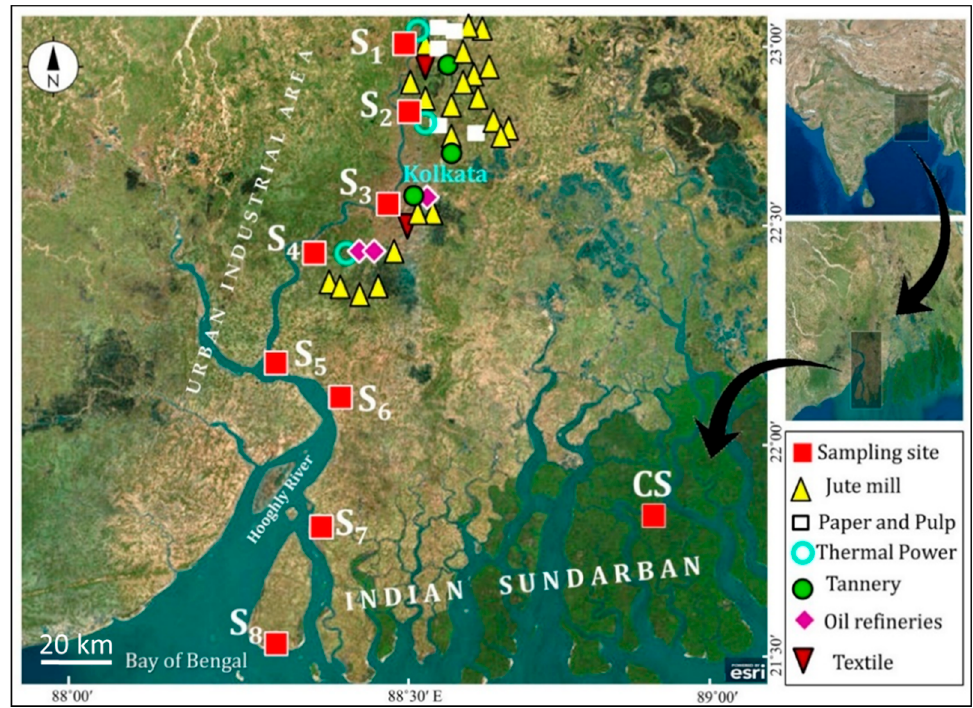
Figure 1. Map showing the location of 8 sampling sites (S 1 –S 8 ) along the Hooghly (Ganges) River Estuary along with the control site (CS) situated in the core area of Indian Sundarban mangrove wetland.